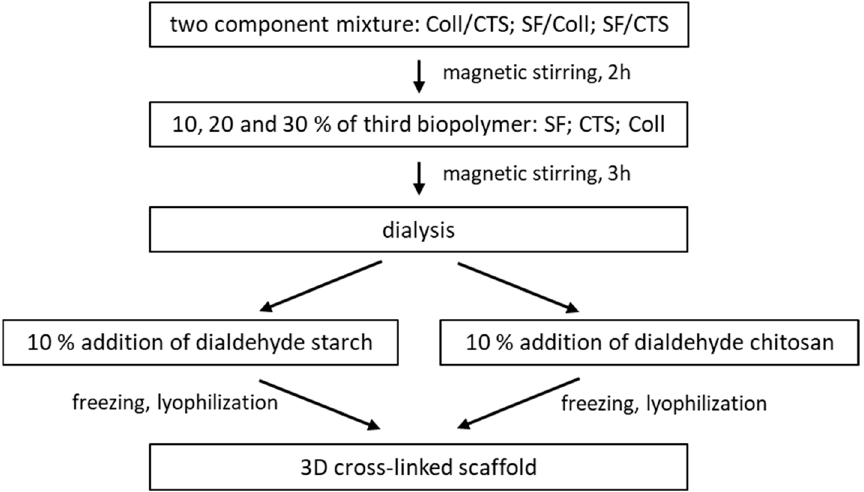
Figure 16. The scaffolds preparation scheme.